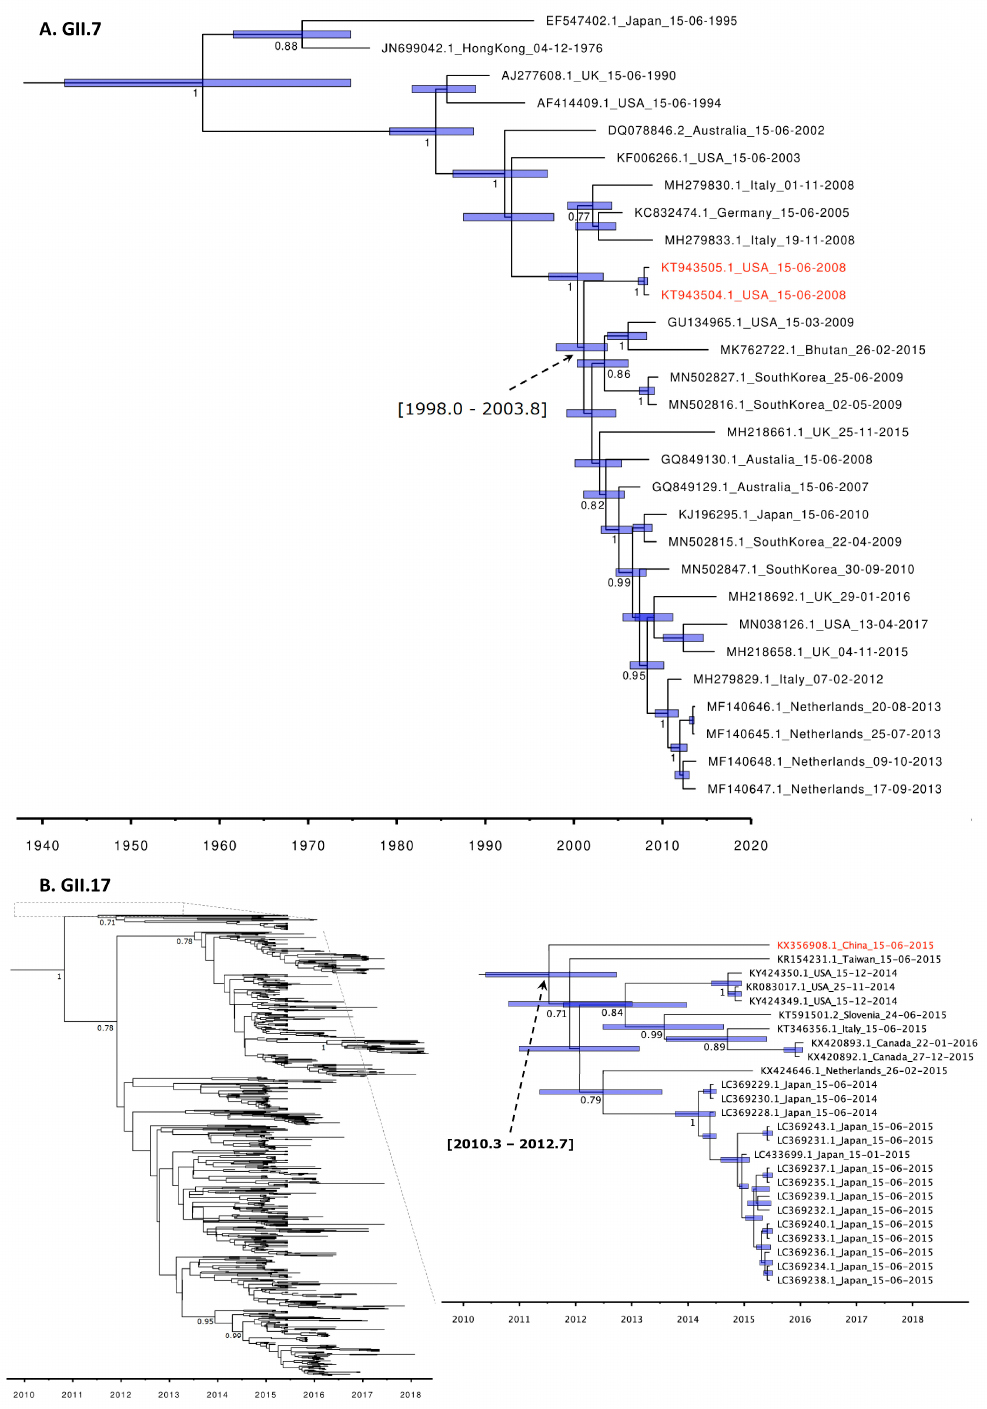
Figure 4. Molecular clock phylogeny of the complete VP1 gene sequences for GII.7 ( A ) and GII.17 (Kawasaki308 cluster) ( B ) constructed by the Bayesian Markov chain Monte Carlo (MCMC) method. Sequences in red indicate sequences from animal origin. Node bars indicate the 95% HPDs of the time of the most common recent ancestor. Numbers in the nodes show the posterior densities (only values >0.7 are shown). The expanded GII.17 tree is shown in Supplementary Figure S1.